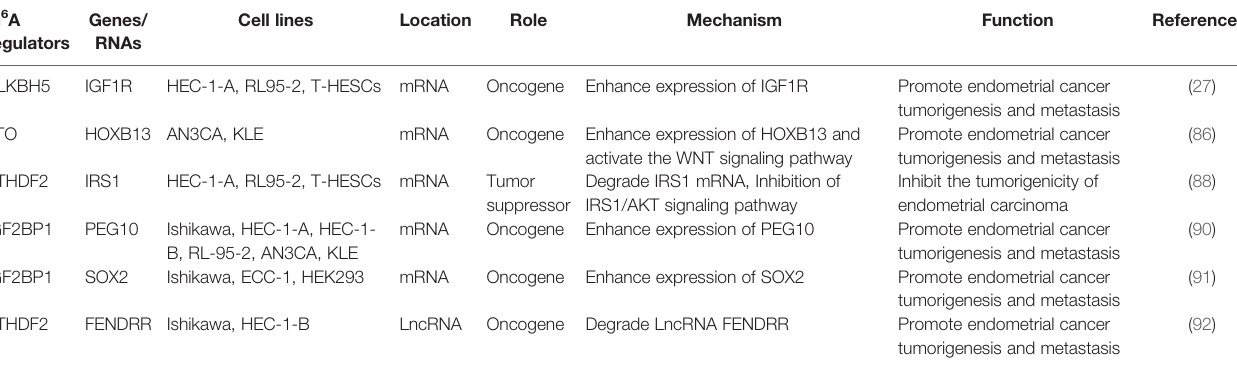
TABLE 2 | The roles of different m 6 A regulators in regulating RNAs in endometrial cancer. m 6 A